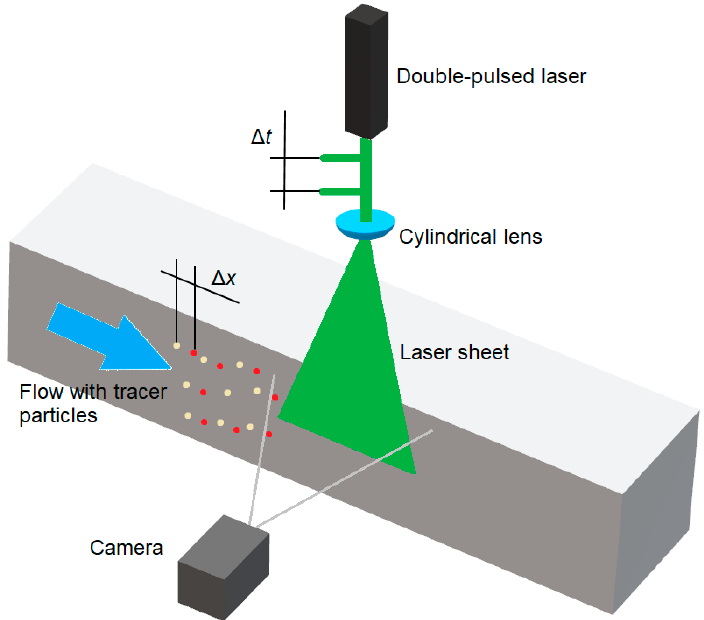
Figure 1. Diagram illustrating the principle of the particle image velocimetry (PIV) method.